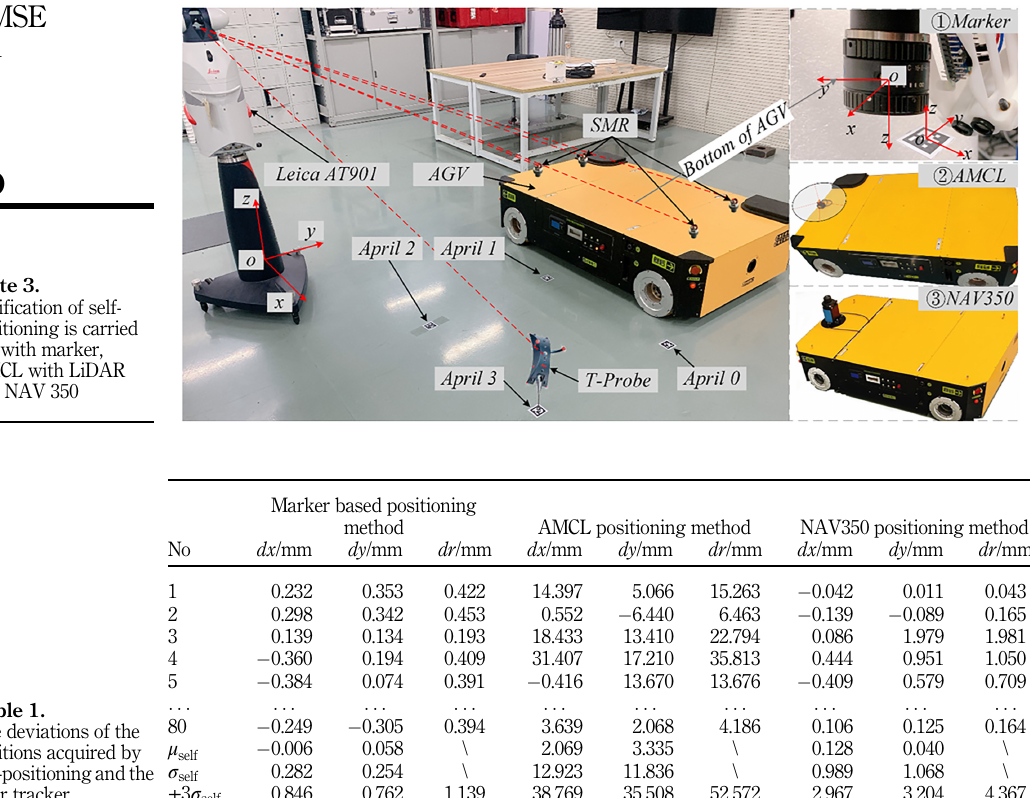
Table 1. The deviations of the positions acquired by